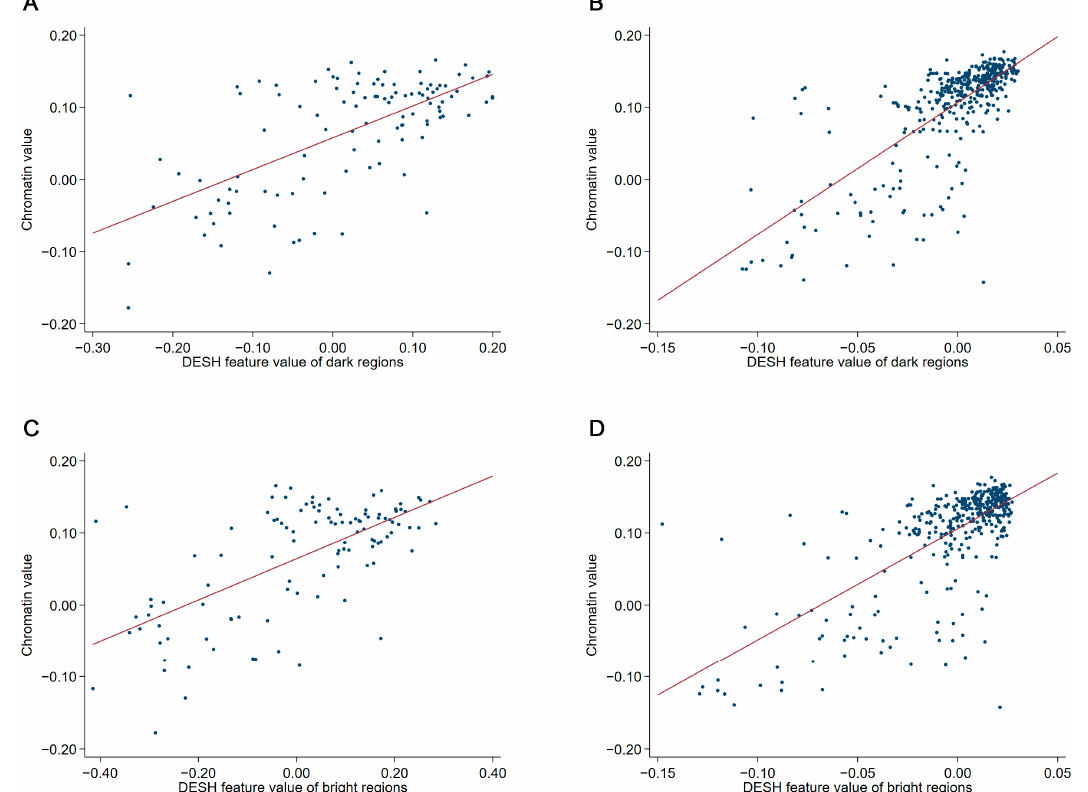
Figure 2. Scatter plots of the chromatin value, i.e., feature value of the marker of chromatin heterogeneity, and the feature values of the marker of diversity of chromatin compartments. ( A ) The chromatin value vs. the DESH feature value of dark regions in the test subset of the ovarian carcinoma cohort. Pearson correlation coefficient was 0.64 (95% CI, 0.51 to 0.74). ( B ) The chromatin value vs. the DESH feature value of dark regions in the test subset of the endometrial carcinoma cohort. Pearson correlation coefficient was 0.73 (95% CI, 0.68 to 0.77). ( C ) The chromatin value vs. the DESH feature value of bright regions in the test subset of the ovarian carcinoma cohort. Pearson correlation coefficient was 0.65 (95% CI, 0.52 to 0.74). ( D ) The chromatin value vs. the DESH feature value of bright regions in the test subset of the endometrial carcinoma cohort. Pearson correlation coefficient was 0.70 (95% CI, 0.64 to 0.75). DESH, dual entropy sum histogram. Table 1. Classification performance of markers of chromatin entropy.